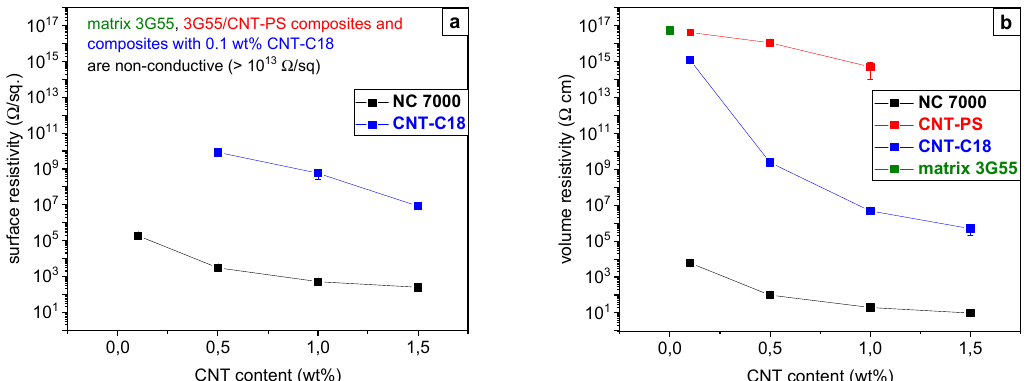
Figure 11. ( a ) Surface resistivity and ( b ) volume resistivity of BCP / MWCNT composites as a function of CNT content.